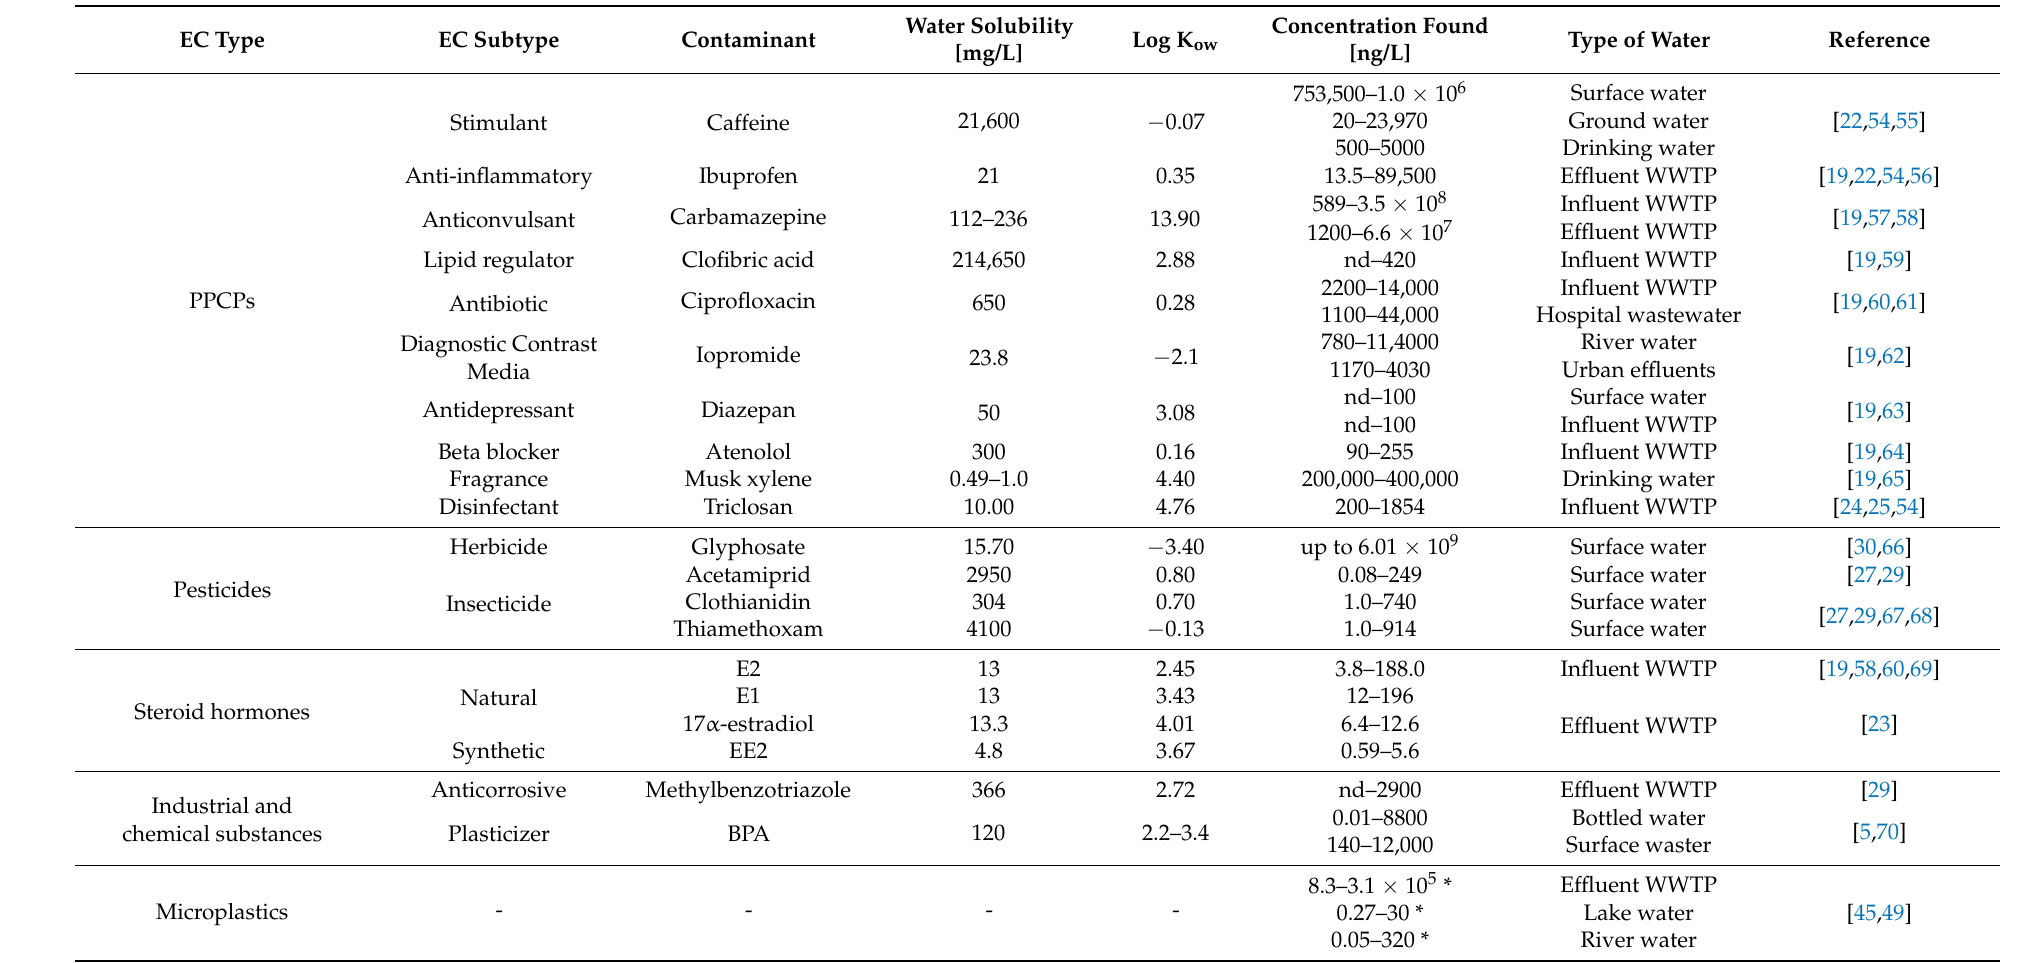
Table 1. Physical and chemical characteristics of some ECs and their concentrations in water